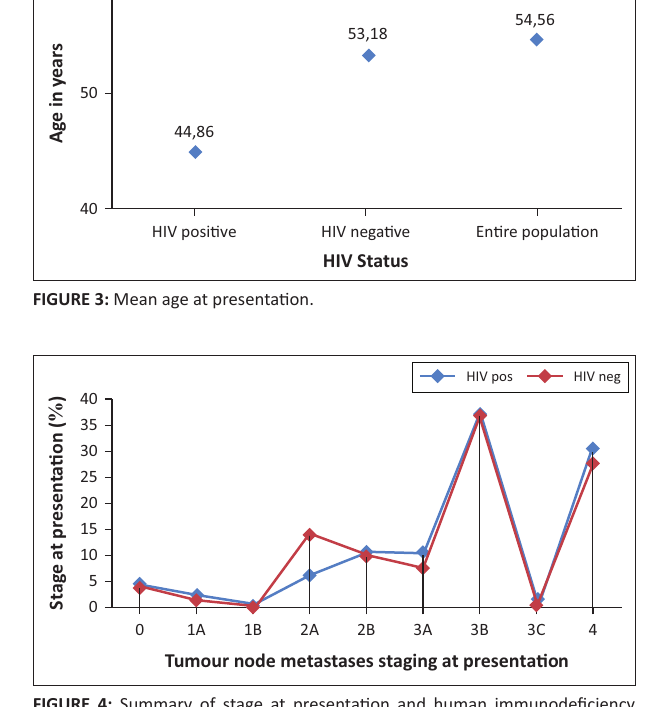
FIGURE 4: Summary of stage at presentation and human immunodeficiency virus